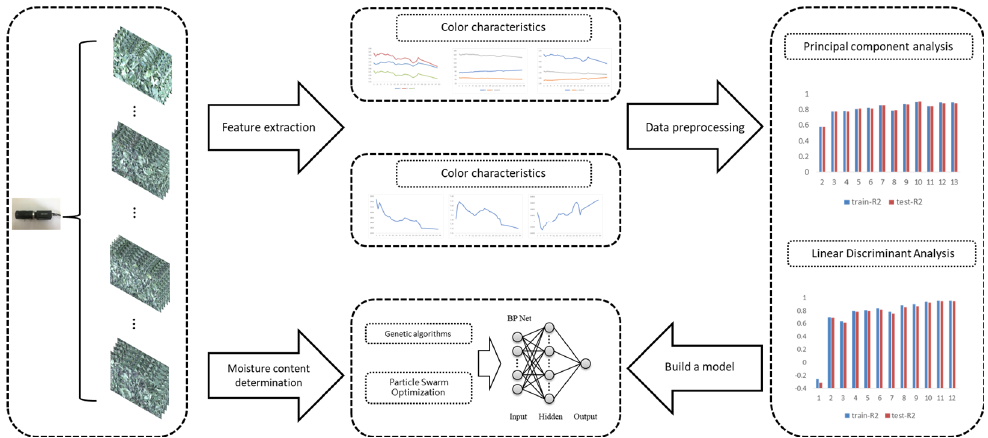
Figure 7. Structure diagram of the moisture content detection model for Yinghong No. 9 tea leaves.